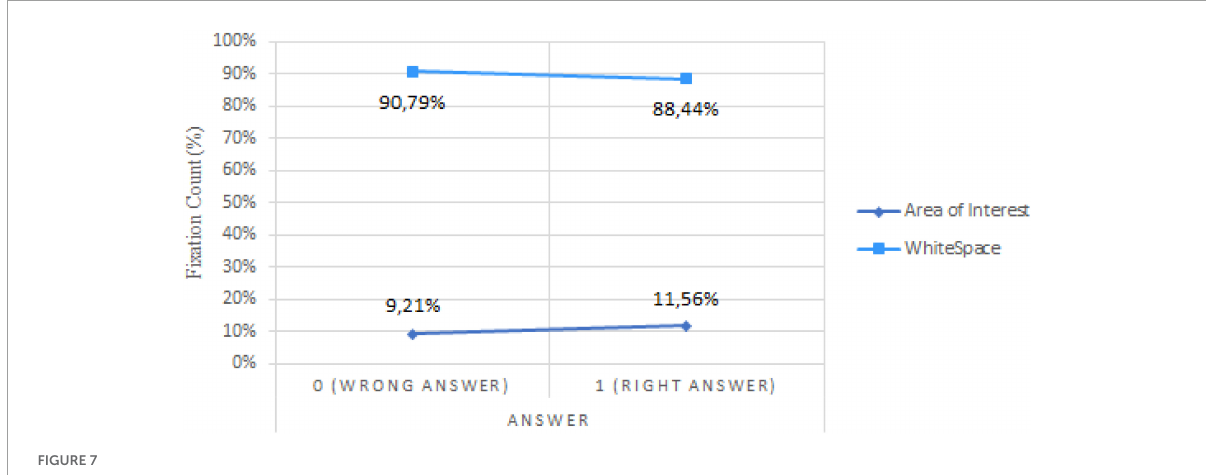
FIGURE7 Fixation count by AOI and answer.